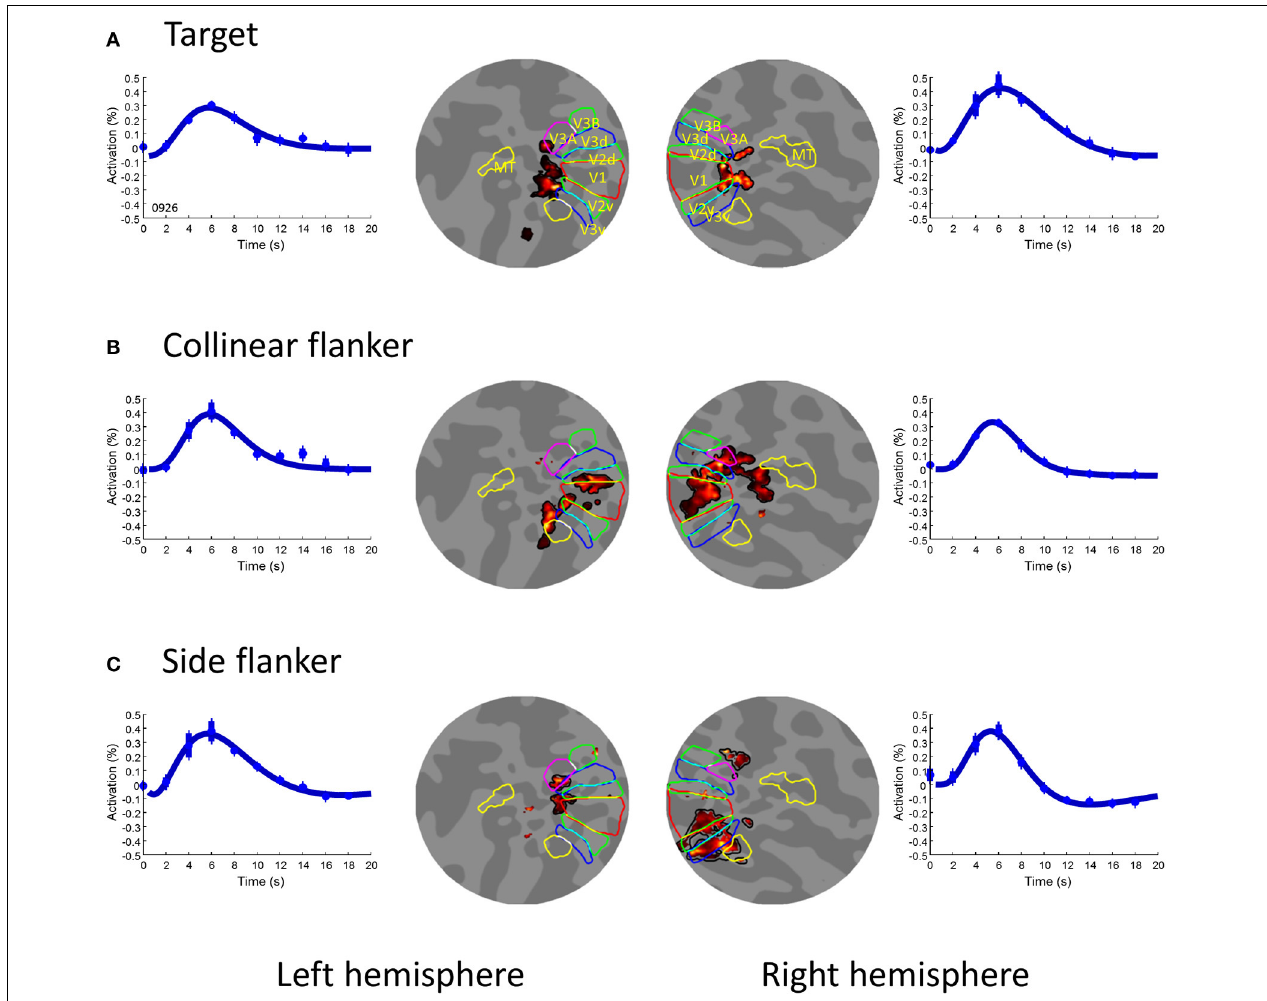
FIGURE 2 | The first order activation for the three image components. (A) the target, (B) the collinear flanker, and (C) the side flanker. In each row, the two inner insets illustrated voxels (pseudo-colored area) showing significant [ t (253) > 4 . 72] activation to the respective image component on a flat map in the left and right hemispheres respectively. The colored contours